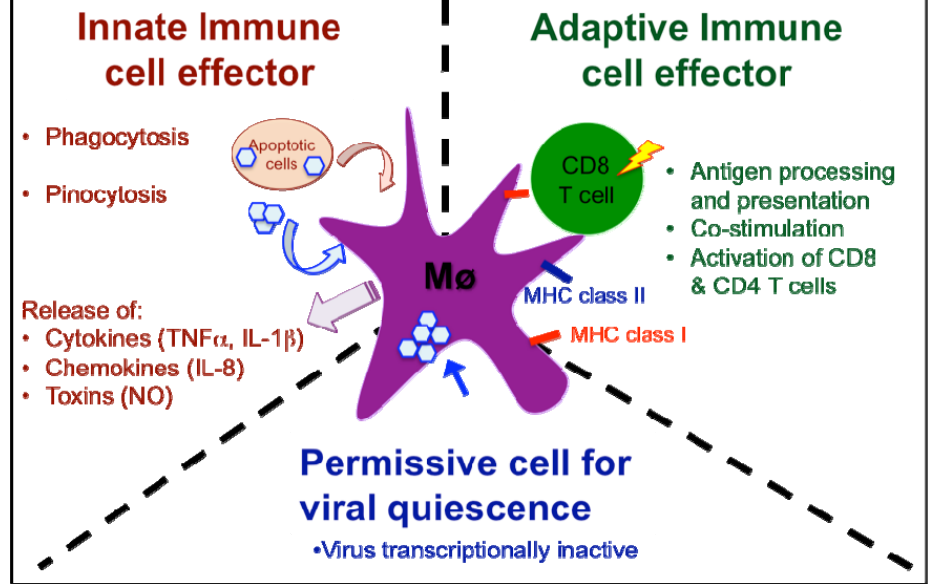
Figure 3. Schematic view of the complex role of macrophages in Xenopus host defenses against RV. As innate immune cell effectors, macrophage can acquire viral antigen by direct infection, pinocytosis of opsonized viruses or phagocytosis of infected cells, as well as release cytokines, chemokines and toxins that contribute to limiting the infection. As an adaptive immune cell effector, macrophages process and present viral antigens through MHC class I and class II pathways, up-regulated co-stimulatory molecules (B7, CD40) and activate anti-RV CD8 and CD4 T cells. Finally, macrophage can harbor quiescent RV in asymptomatic